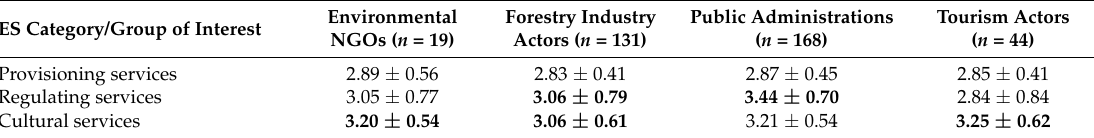
Table 4. Stakeholders’ preferences for three ES categories by groups of interest (mean value).